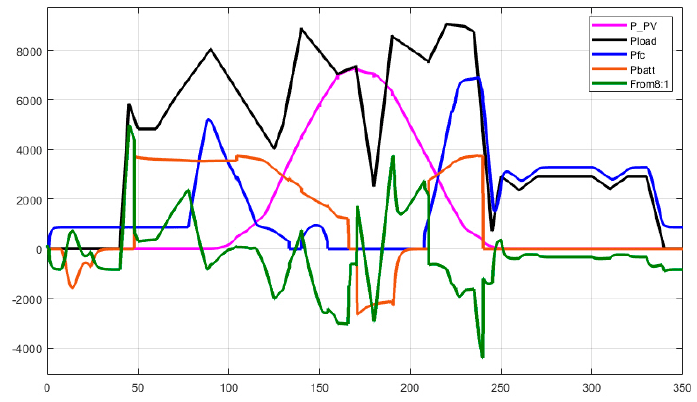
Figure 20. All power sources along the simulation period.